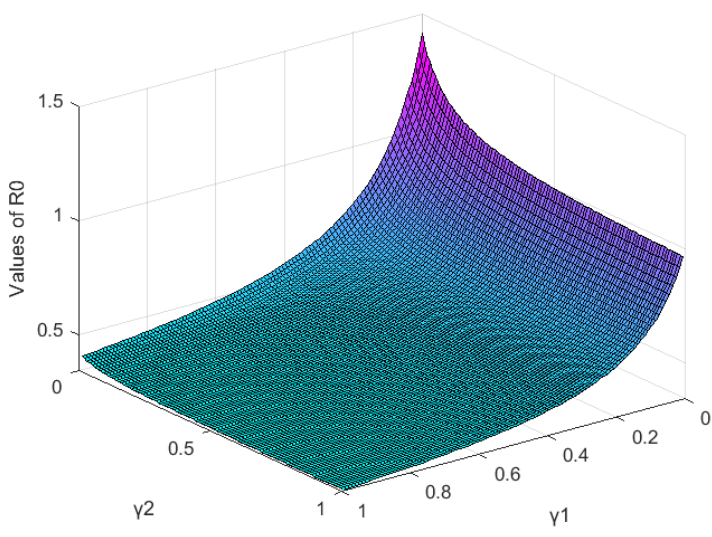
Figure 9. Influence of control variables on the basic reproduction number R 0 .